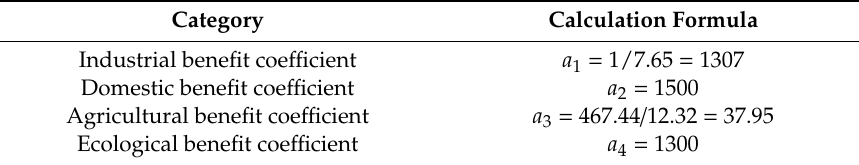
Table 4. Economic benefit coe ffi cients (units = CNY / m 3